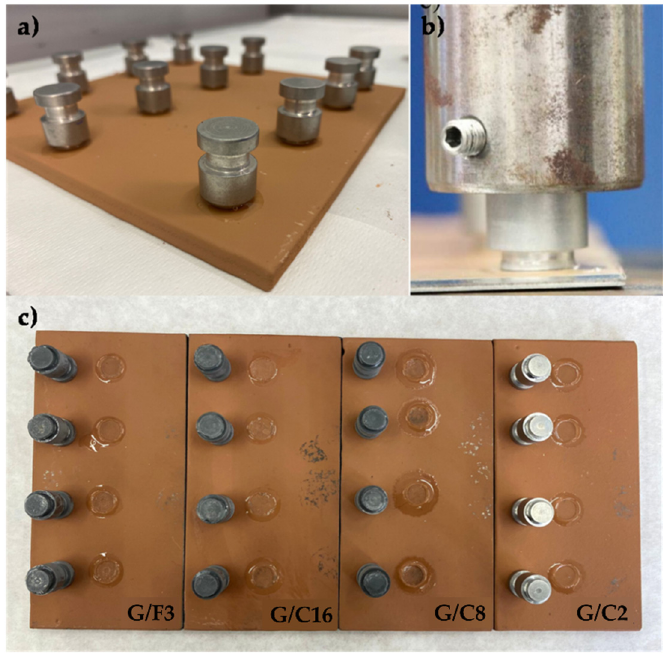
Figure 9. Pull-off test of the G/F3 coating ( a ); fixing phase of the dolly in the dynamometer ( b ); image of the dolly detached after the pull off test ( c ).